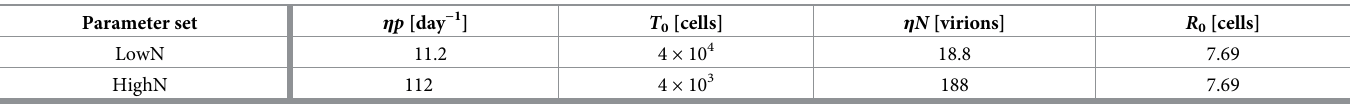
Table 2. Model parameters used in the stochastic simulations. Parameter